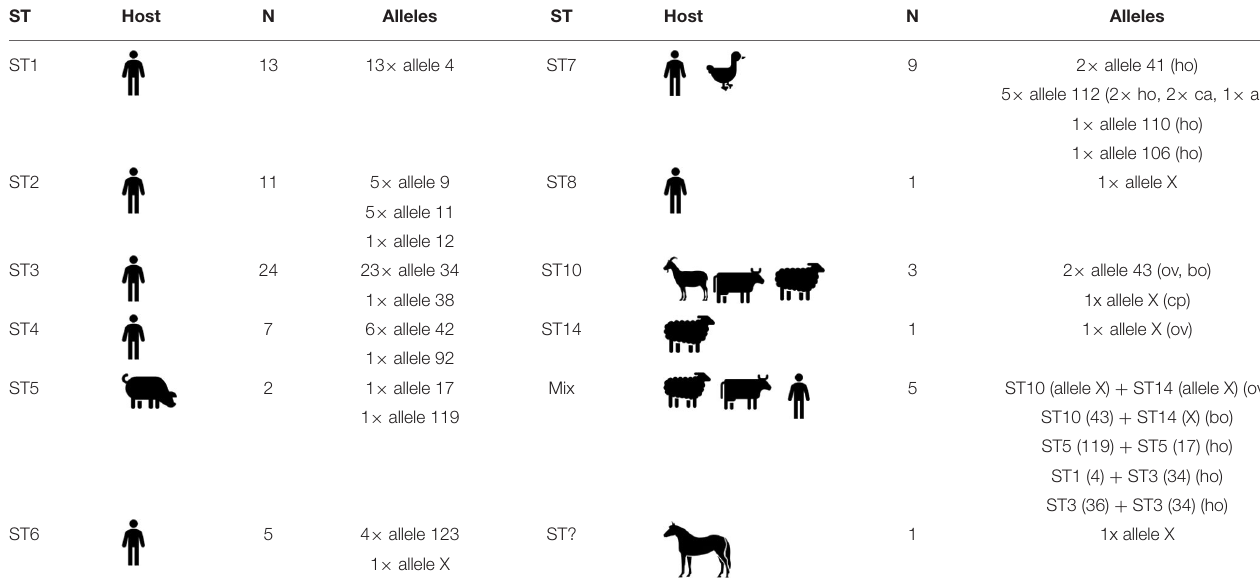
TABLE 4 | Intra-subtype variability of detected Blastocystis subtypes according to host. ST Host N Alleles ST Host N Alleles ST1 13 13 × allele 4